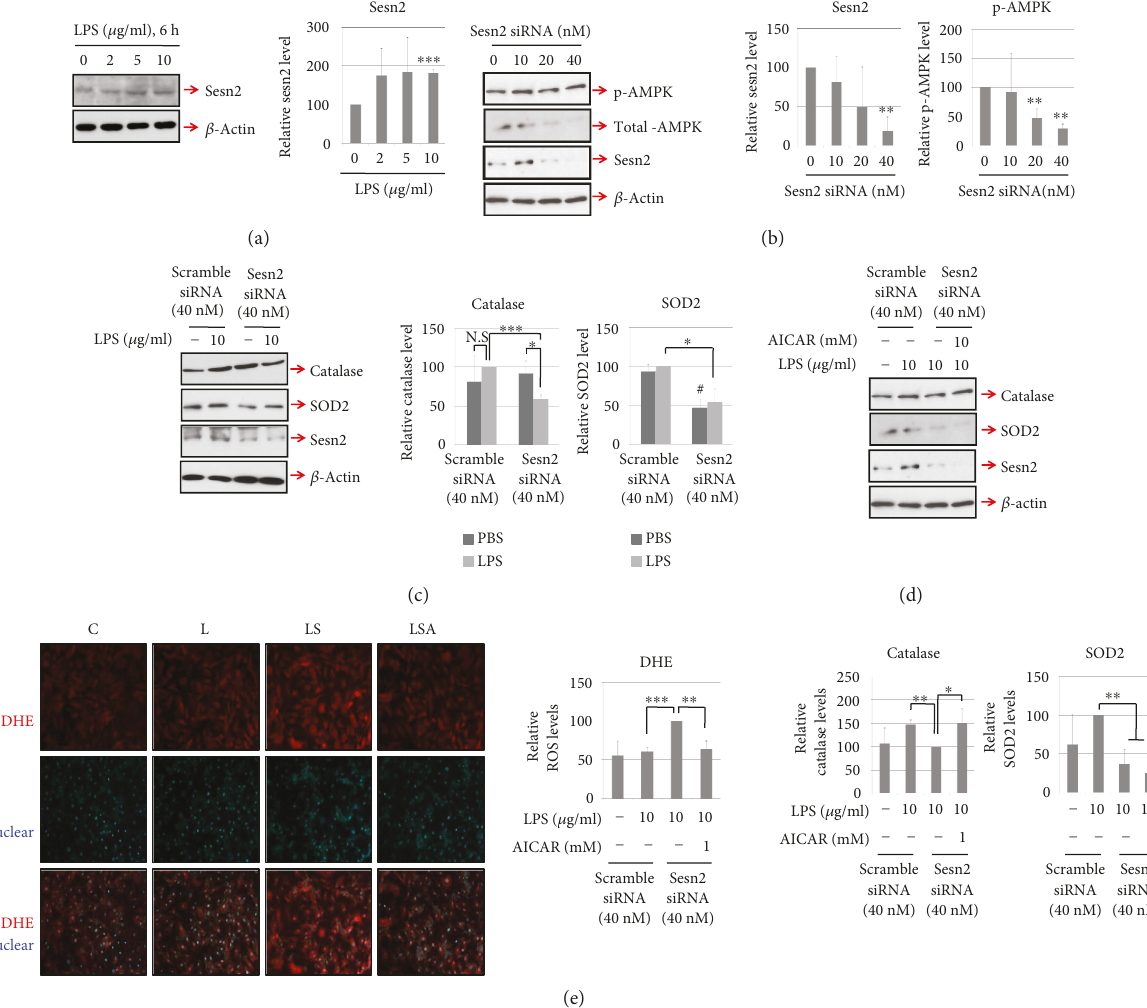
Figure 1: Sesn2 knockdown increases LPS-mediated oxidative stress through an AMPK-dependent pathway in H9c2 cells. (a) H9c2 cells were stimulated with various doses of LPS for 6 h. (b) siRNA targeting rat sesn2 was transfected into H9c2 cells, and the level of phosphorylated AMPK was determined by Western blotting. (c and d) Sesn2 knockdown H9c2 cells were incubated with LPS or LPS plus AICAR for 4h. Western blotting was then used to determine the levels of catalase and SOD2. (e) Sesn2 knockdown cells were stimulated with LPS or LPS plus AICAR for 6 h, after which ROS levels were analyzed by DHE staining (red). All graphs were obtained from three separate experiments. Data are presented as means; error bars represent ± SD (NS: not signi fi cant; # P < 0 05 versus control; ∗ P < 0 05 ; ∗∗ P < 0 005 ; ∗∗∗ P < 0 0005 ;